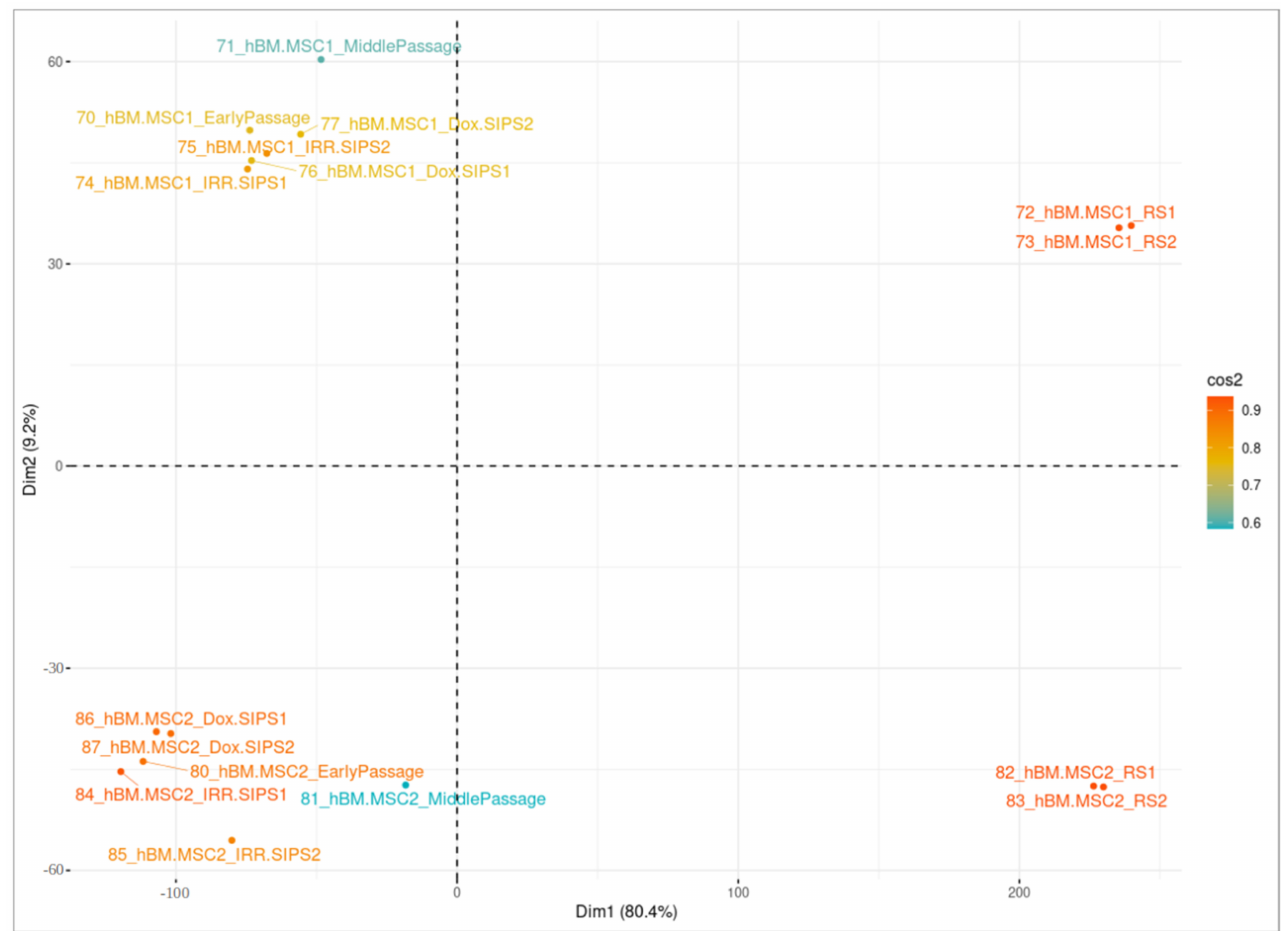
Figure 4. Visualization of cluster analysis in hBM-MSC samples. Principal component analysis (PCA) was performed on normalized β -values of unique differentially methylated positions in cells after a middle number of passages (MidPass), in replicative senescence (RS), in stress-induced premature senescence after exposure to ionizing irradiation (IRR-SIPS) and doxorubicin (Dox-SIPS). X-axis “Dim1” corresponds to the first principal component of PCA, and Y-axis “Dim2” to the second principal component. The percentage of total variability explained by the component is indicated in brackets. Colors reflect the quality of representation on the cluster map (cos2). Labels correspond to samples (for detailed explanation of sample identifiers, consult Figure